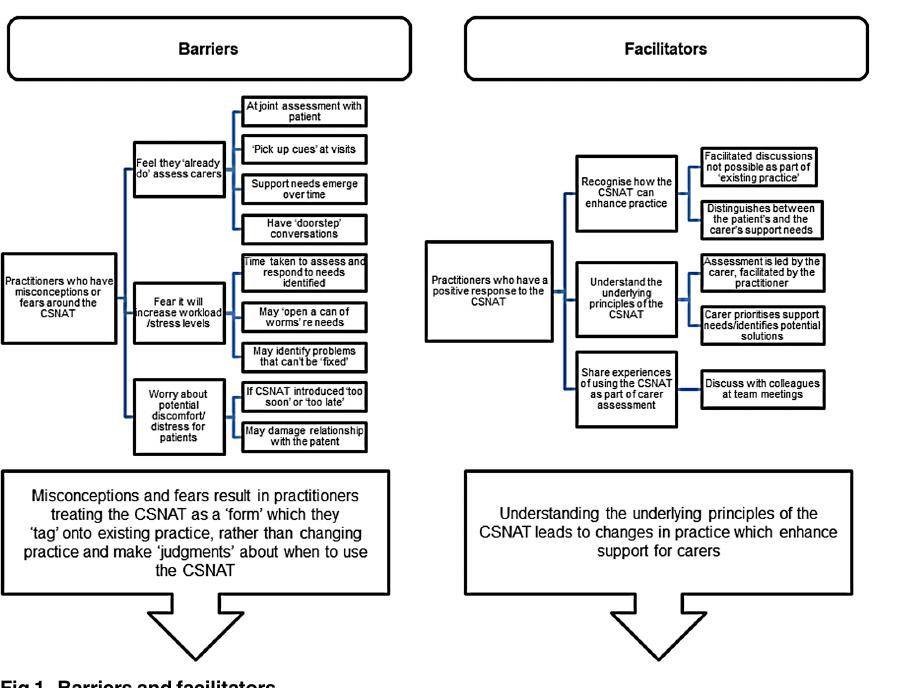
Fig 1. Barriersand